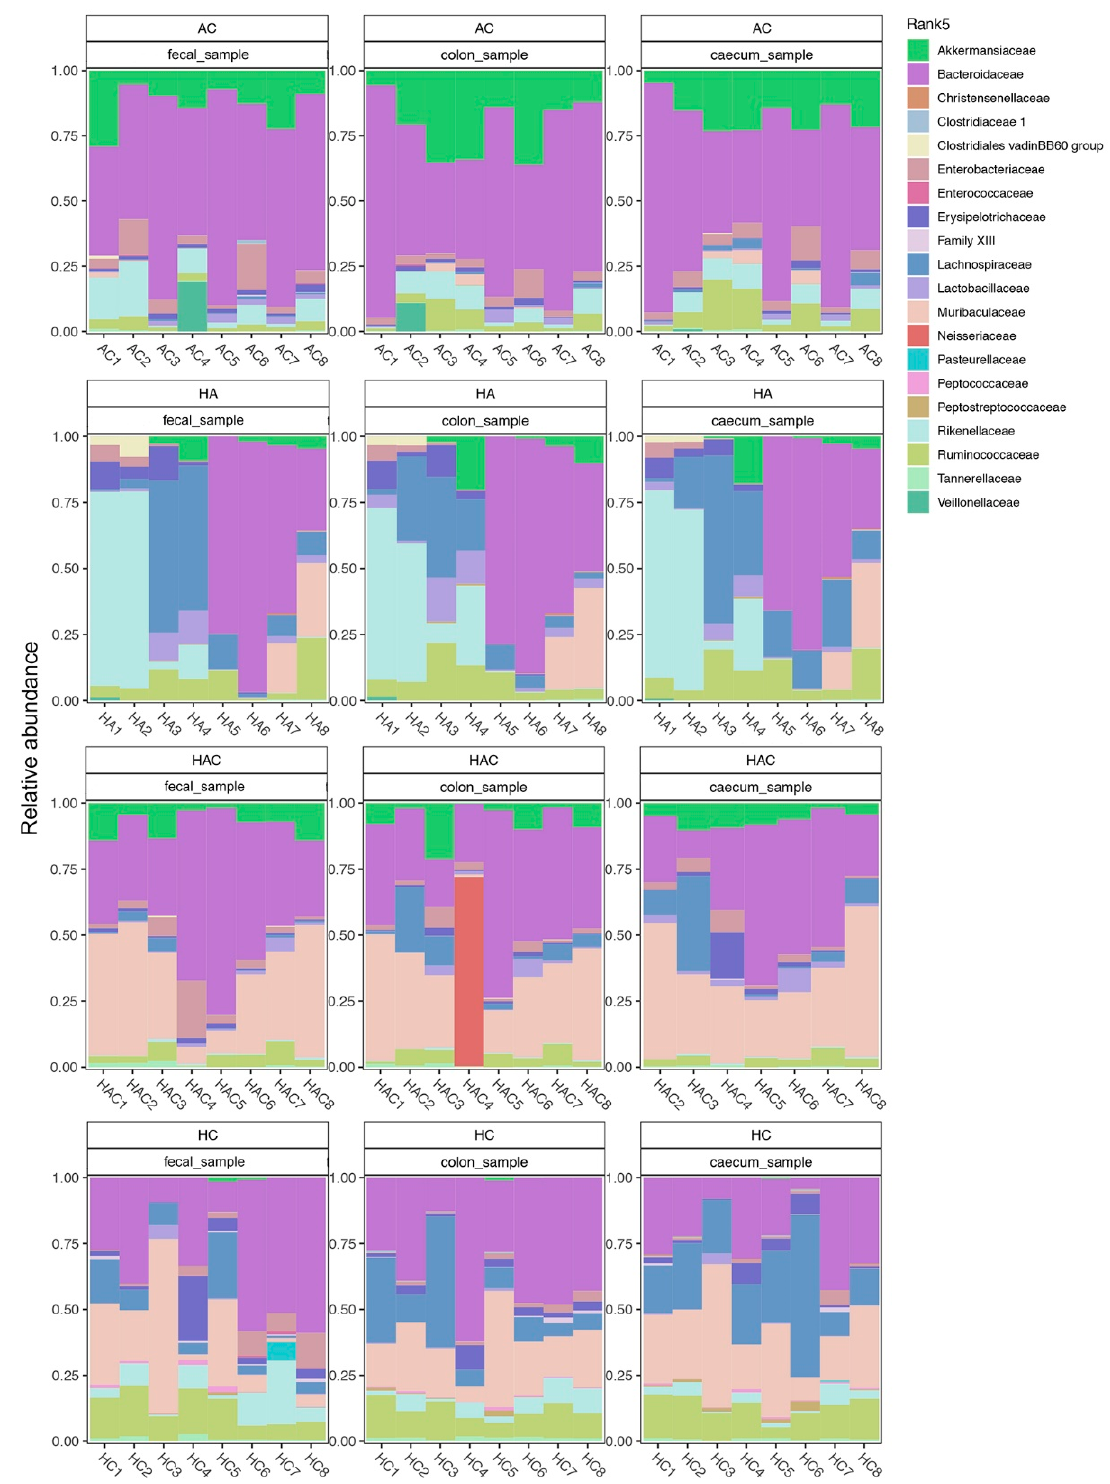
Figure 5. Summary of the bacterial taxa in the microbiota for each experimental group on Day 31. The microbial diversity and composition in each experimental group (AC, HA, HAC, and HC) is compared in three types of samples, specifically fecal samples, caecum, and colon. In each group and for each type of sample, the composition of the microbiota is shown in all individual rats. Rats were housed in pairs over the course of the experiment (i.e., nb.1 with nb.2, nb.3 with nb. 4, nb.5 with nb. 6, and nb.7 with nb. 8 in each group).